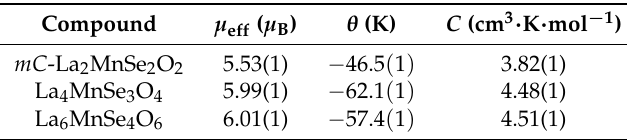
Table 4. Effective magnetic moments ( µ eff ), Weiss-constants ( θ ), and Curie-constants ( C )